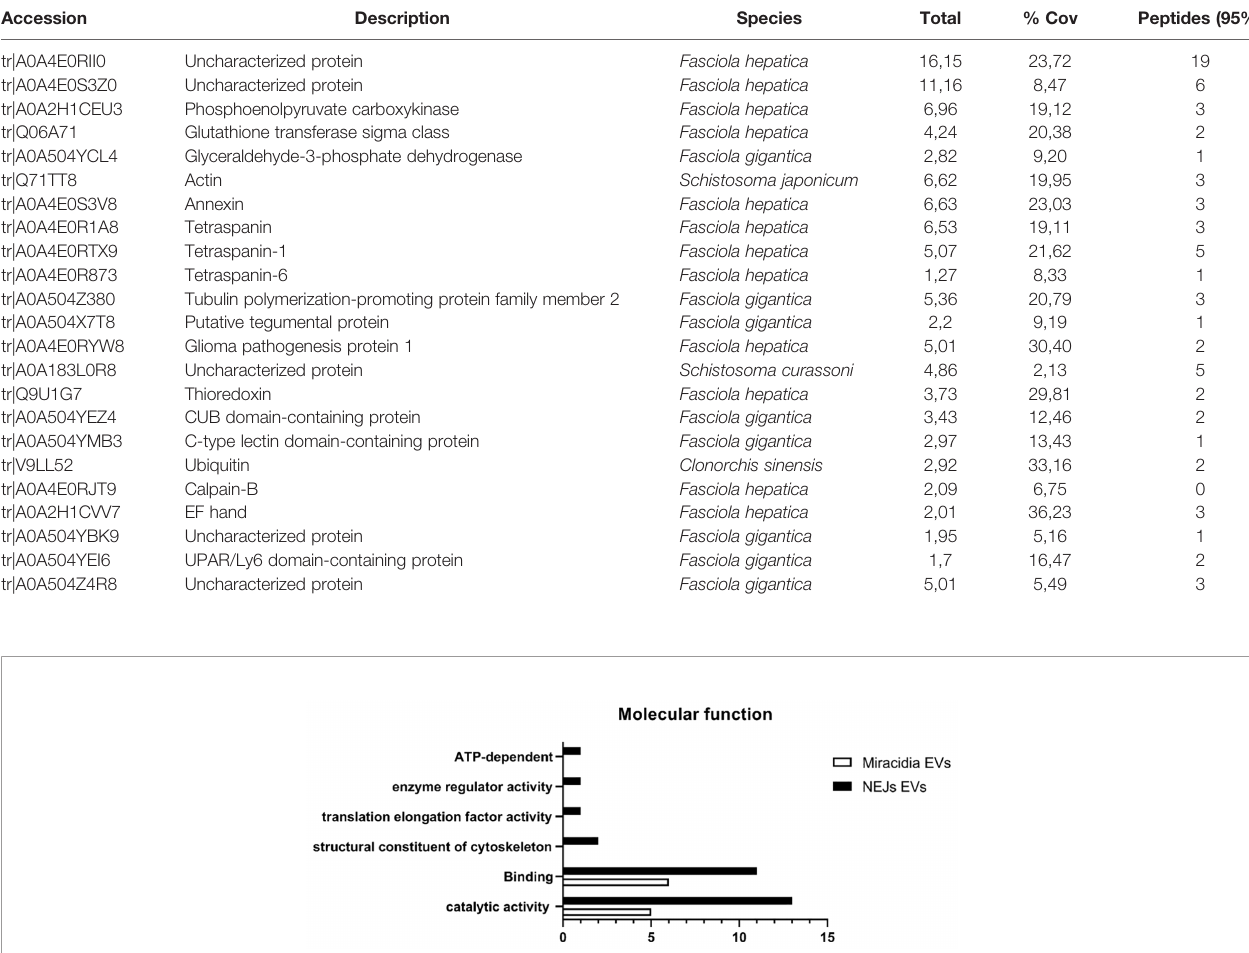
TABLE 1 | Identi fi cation of proteins within the EVs of F. hepatica eggs/miracidia isolated by SEC and analyzed by LC-MS/MS.